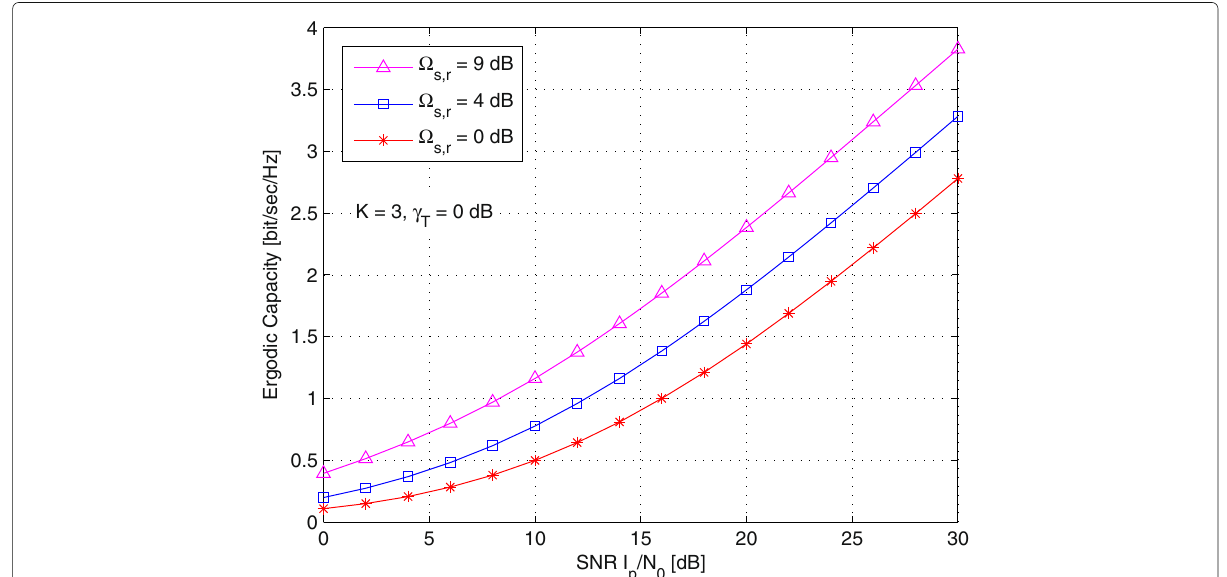
Fig. 9 Channel capacity vs SNR of cognitive AF relay network with MUSwiD user selection scheme for different values of (cid:3) s,r and (cid:3) s,p = 10, and = 1, (cid:3) = 2, (cid:3) = 3 for k = 1, ... (cid:3) s,r r,p r, k